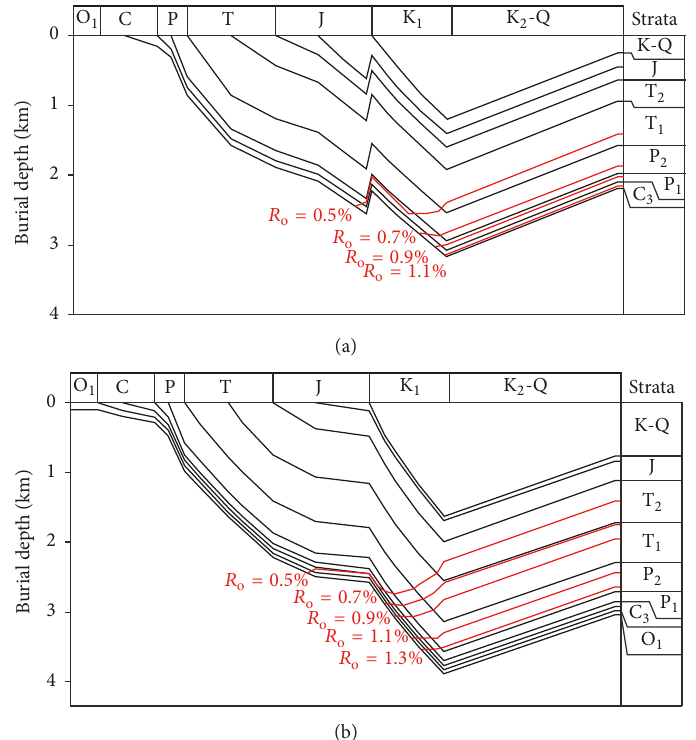
Figure 10: Burial and thermal evolution histories of the major stratigraphic intervals at the locations of Well JP1 in the Shiguhao gas zone (a) and Well J10 in the Shilijiahan gas zone (b) in the Hangjinqi area (modified after Hao et al. [31]).